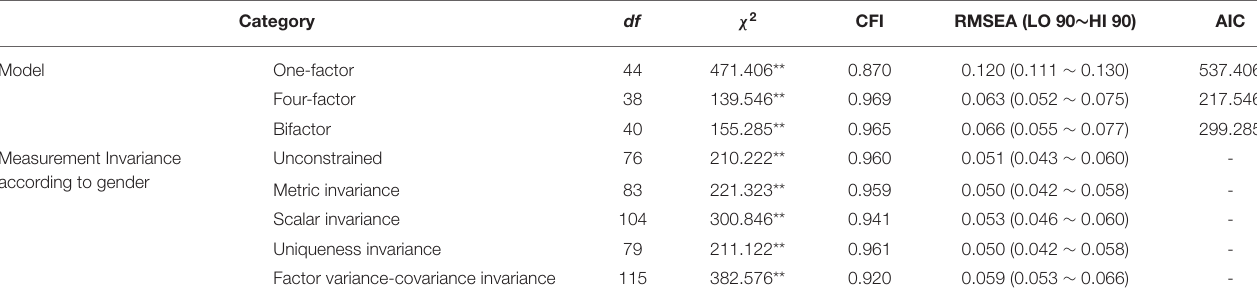
TABLE 2 | Comparison of three competing models of the CES-D-11 and measurement invariance. Category